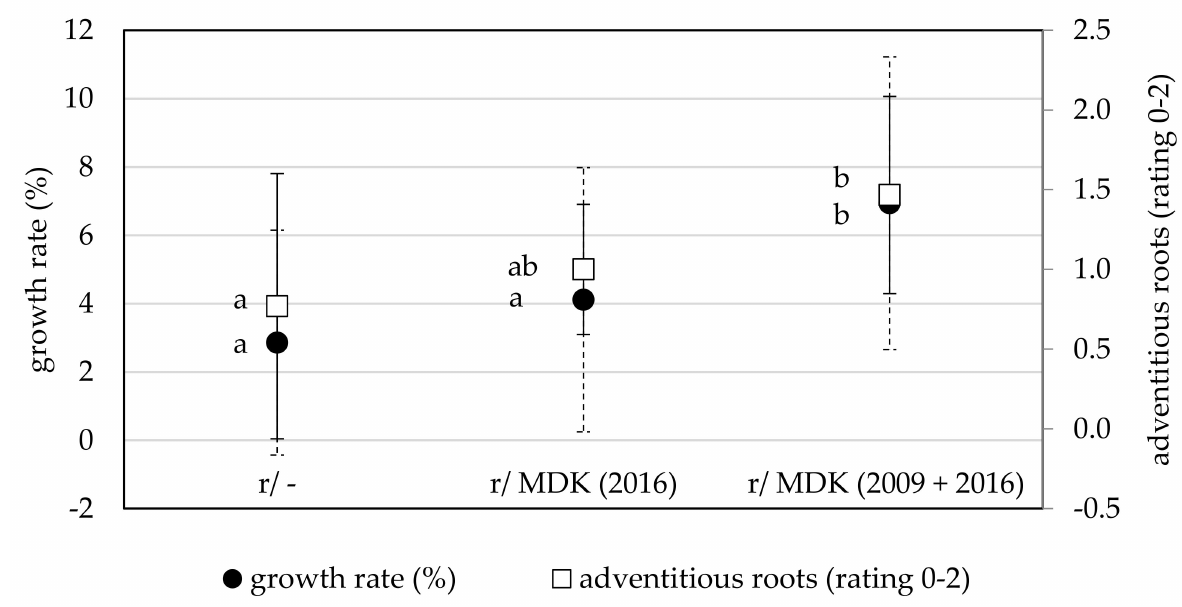
Figure 3. MDK Field Test - Parallels between vegetative growth (%) (17 November to 18 January) and rating of adventitious, January 2018. Significances calculated between test-variants, α = 0.05, relative standard deviation.